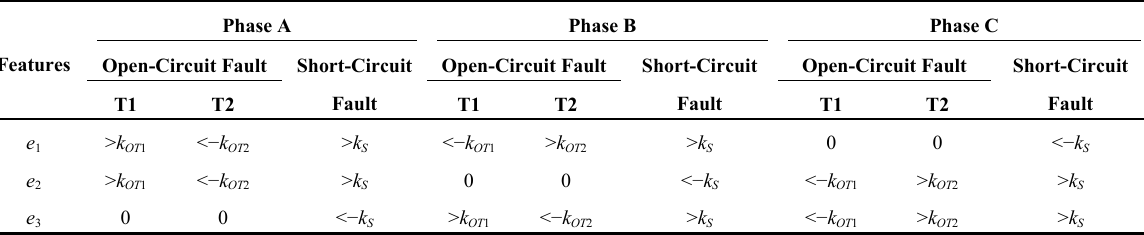
Table 5. Detection for Power Device Fault in Phase